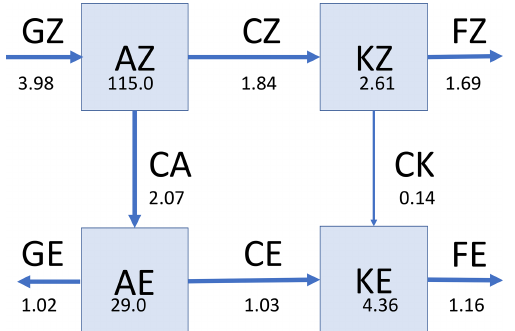
Figure 7. An example Lorenz energy cycle, computed by Young (2014) from a numerical simulation of an equilibrated baroclinic wave flow in a differentially heated, rotating annulus. Energy reser- voir and conversion and source/sink terms are in units of 10 − 7 joules per kilogram and watt per kilogram respectively.